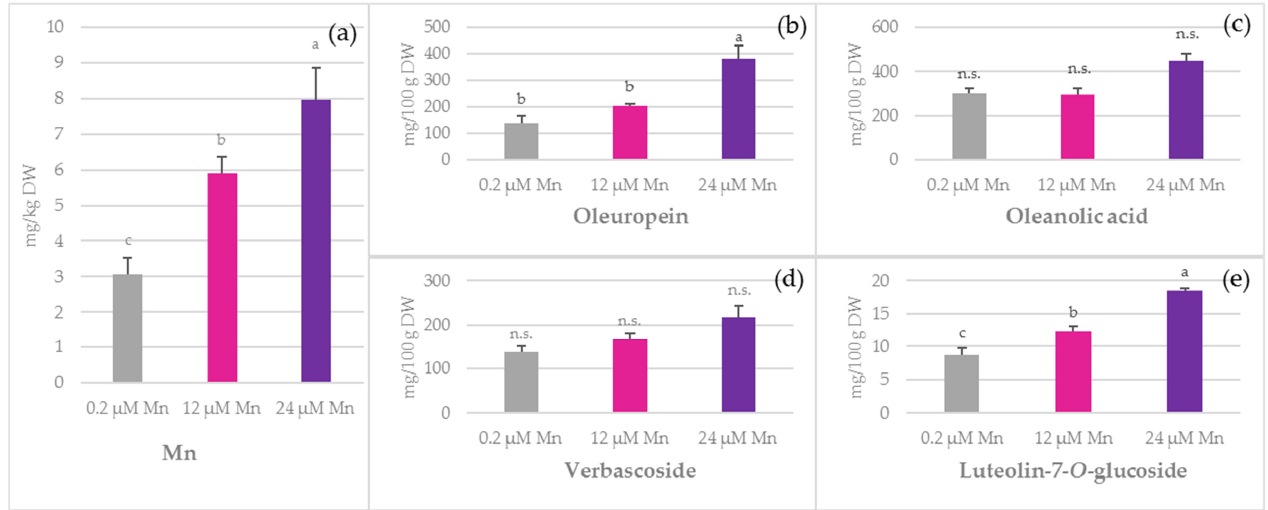
Figure 2. The effect of manganese (Mn) application on: ( a ) Mn, ( b ) oleuropein, ( c ) oleanolic acid, ( d ) verbascoside, and ( e ) luteolin-7- O -glucoside concentrations in olive stems of ‘Istarska bjelica’ olive cv. (mean values ± SE, n = 4). Mean values followed by different letters are significantly different at p < 0.05 according to Tukey’s test. DW—dry weight.